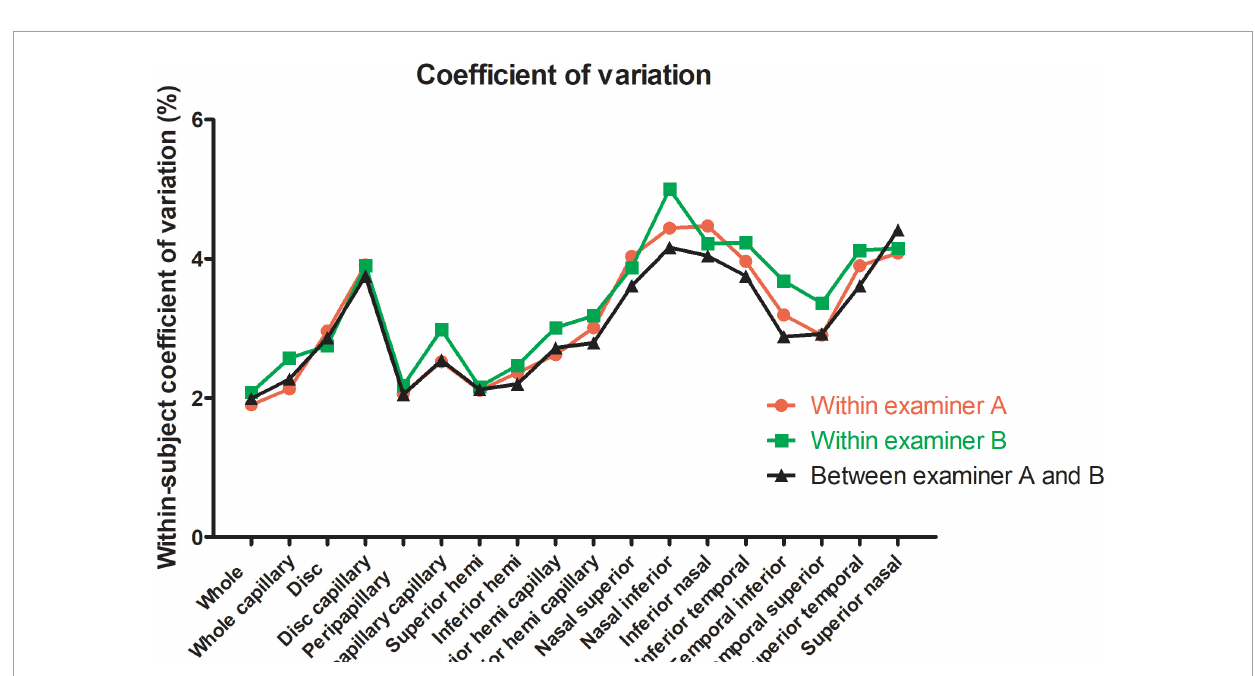
measurements of CD have also been reported in the adult macula (18, 29, 30). Pappelis and Jansonius (17) reported two measurements of pericapillary CD in 30 healthy adult eyes using Canon OCT-HS 100 angiography; the ICC and TRT were 0.79 and 1.8%, respectively. Consistent with this study, the intra-examiner ICC of examiners A/B was 0.757 / 0.691, and